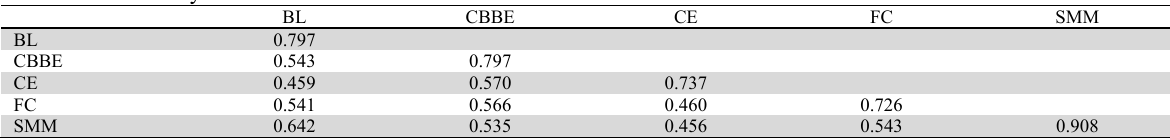
Discriminant validity